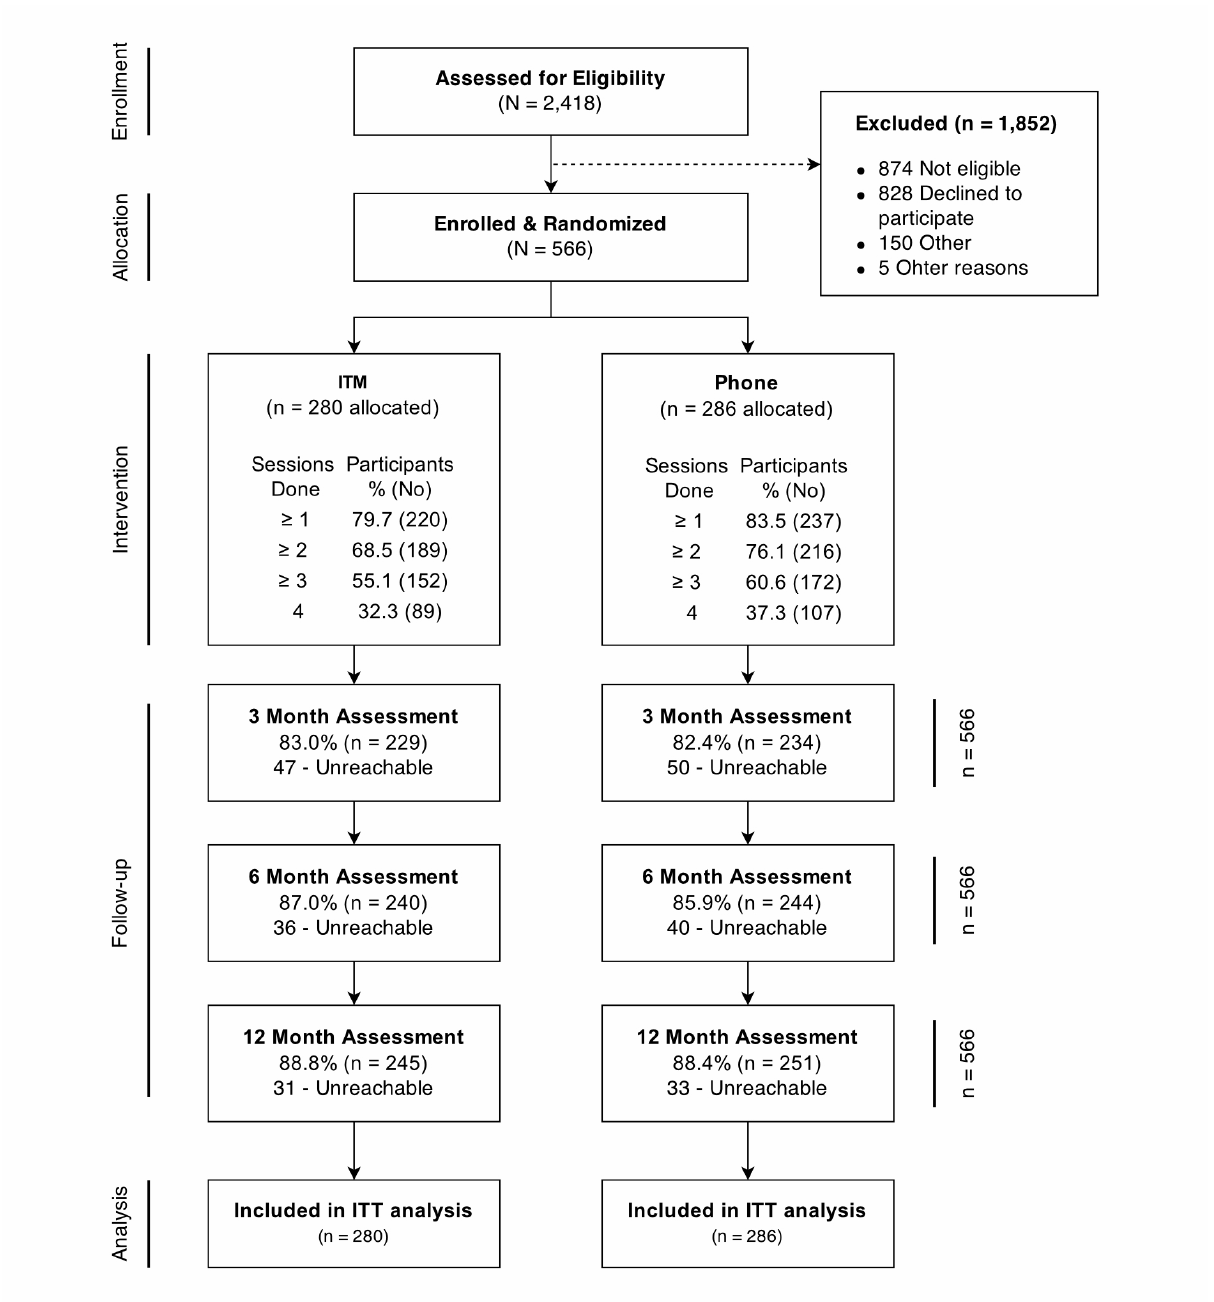
Figure 1. Flow of participants through the trial. Reasons for being dropped from enrolment are not mutually exclusive. Values next to the number